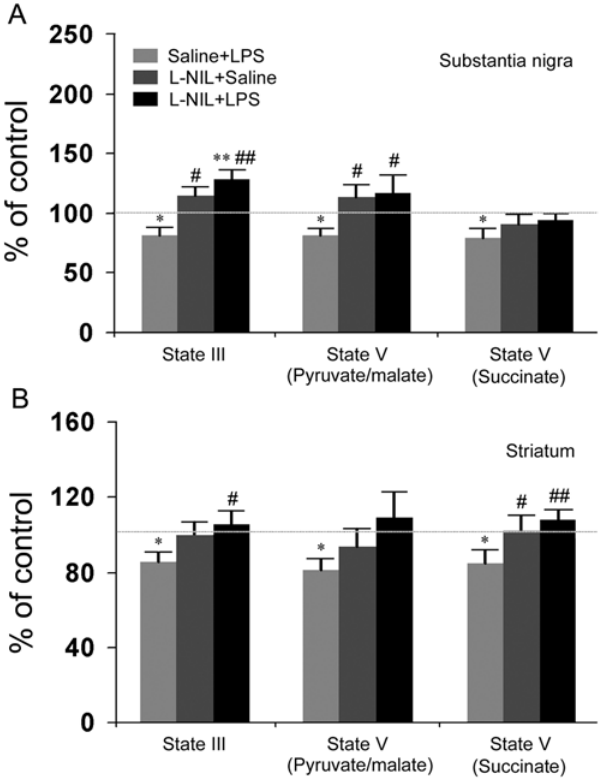
Figure 6. LPS impairs nigrostriatal mitochondria respiration. (A) Functional impairment occurs in the nigral mitochondria as LPS significantly decreases state III and state V respiration when driven by both complex I and complex II substrates. Treatment of L-NIL, an iNOS inhibitor prevents LPS-induced mitochondrial dysfunction (n=6/group; * p , 0.05, ** p , 0.01 vs. saline + saline, # p , 0.05, ## p , 0.01 vs. saline + LPS). (B) It appears that there is a significant decrease in state III and state V respiration of striatal mitochondria when driven by both complex I and complex II substrates in the striatum ipsilateral to LPS injection. L-NIL efficiently blocks the neuroinflammation-mediated defect in striatal mitochondrial respiration (n=9/group; * p , 0.05, ** p , 0.01 vs. Saline + Saline, # p , 0.05, ## p , 0.01 vs. Saline +